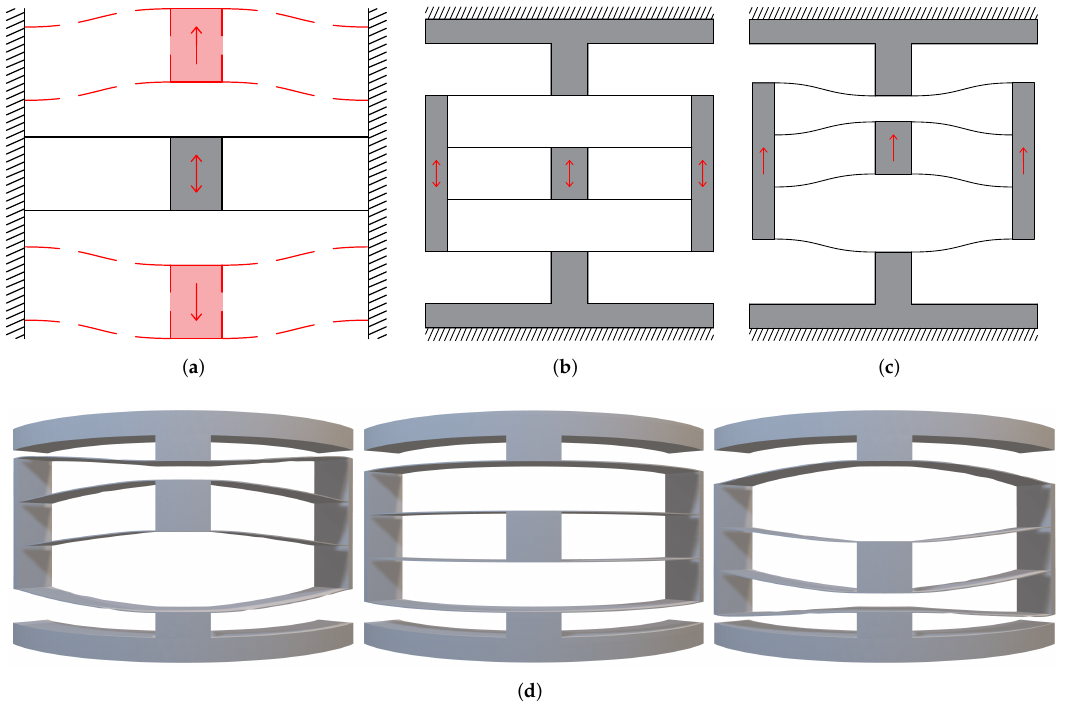
Figure 1. The parallelogram mechanisms. ( a ) The fundamental compound parallelogram mechanism and its deformation. ( b ) Planar CDPM. ( c ) Deformed planar CDPM. ( d ) The deformation process of curved